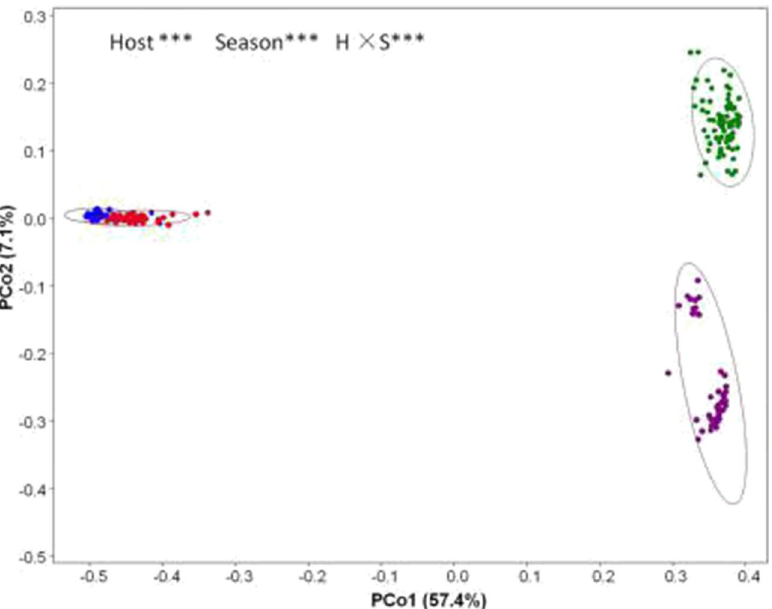
Figure 1. Principal coordinates analysis (PCoA) ordination of the operational taxonomic units (OTUs). Dots indicate one sample and the circles are the 95% ellipses. Colors are as follows: blue = WinY; red = WinS; green = SumY; purple = SumS. Results of PERMANOVA are given in the upper right of each panel: **P < 0.01; ***P <